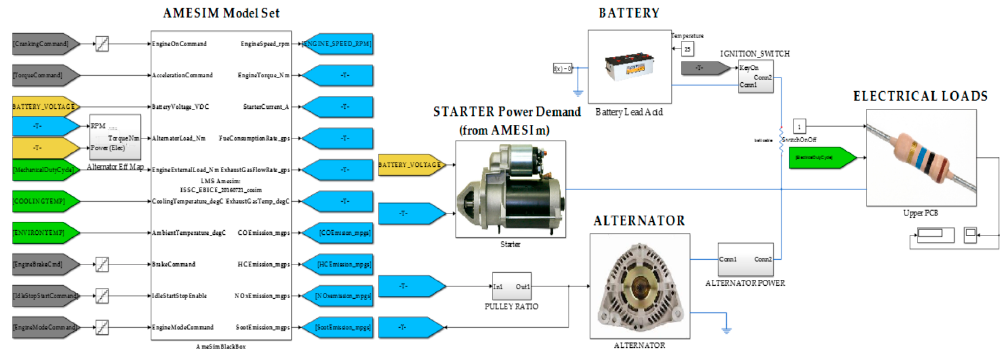
Figure 6. Real-time Simulink powertrain model using AMESim and Simscape.